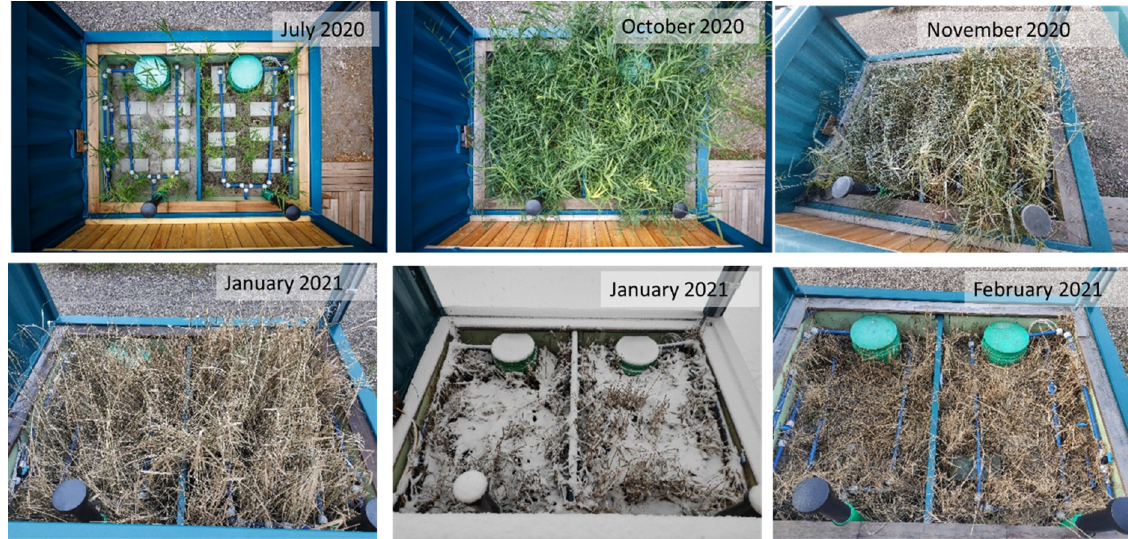
Figure 2. VFCW in different operating phases (Photos: J. Rettig; P. Moosmann).